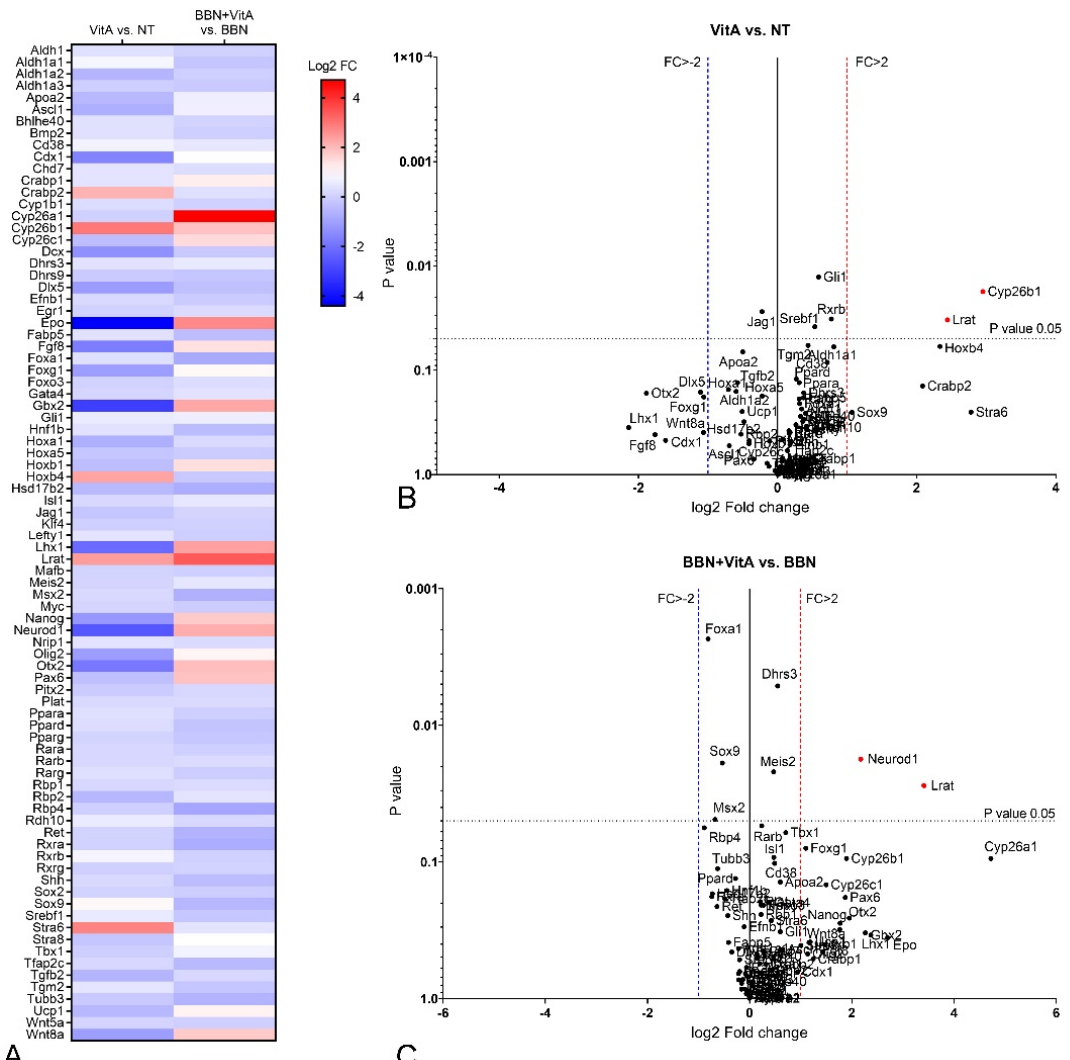
Figure 6. Differential expression of genes involved in retinoic acid signaling in mouse bladder tissue after BBN treatment with or without vitamin A rich diet. Comparisons of NT ( n = 9), VitA ( n = 9), BBN + VitA ( n = 9), and BBN ( n = 9) groups. ( A ) Heatmap representation of fold change in gene expression in VitA vs. NT and BBN + VitA vs. BBN groups. ( B , C ) Volcano plots showing comparison of VitA vs. NT and BBN + VitA vs. BBN groups. For each group, three cDNAs, each containing RNA from three different mice, were used. Significantly affected gene expression with fold change greater then 2, upregulated or downregulated, is marked in red or blue, respectively ( p value < 0.05; tested by two-sided Student’s t test). FC, fold change.